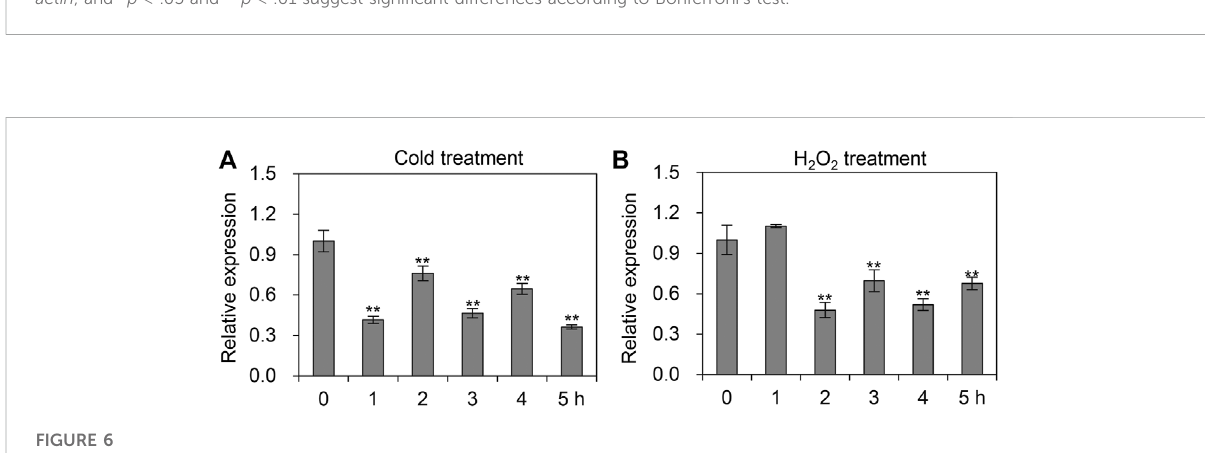
FIGURE 5 Transcriptional levels of AccTid under different pesticide stresses. The transcriptional levels of Tid when A. cerana was exposed to beta- cypermethrin (A) , methomyl (B) , abamectin (C) , imidacloprid (D) , spirodiclofen (E) , bifenthrin (F) and paraquat (G) stress. The internal control was β - actin , and * p < .05 and ** p < .01 suggest signi fi cant differences according to Bonferroni ’ s test.